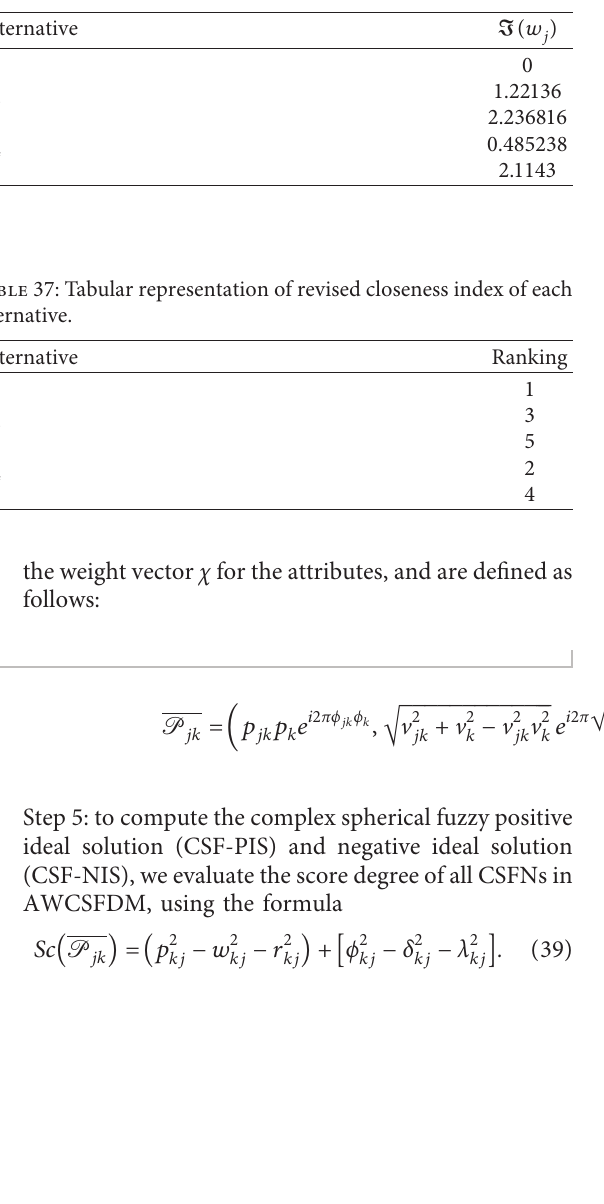
Table 36: Tabular representation of revised closeness index of each alternative.